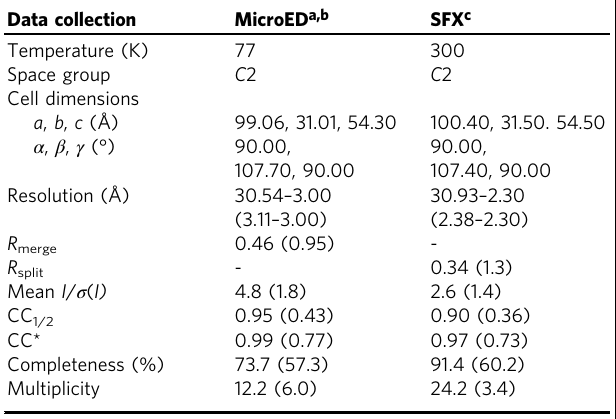
Table 1 Data collection